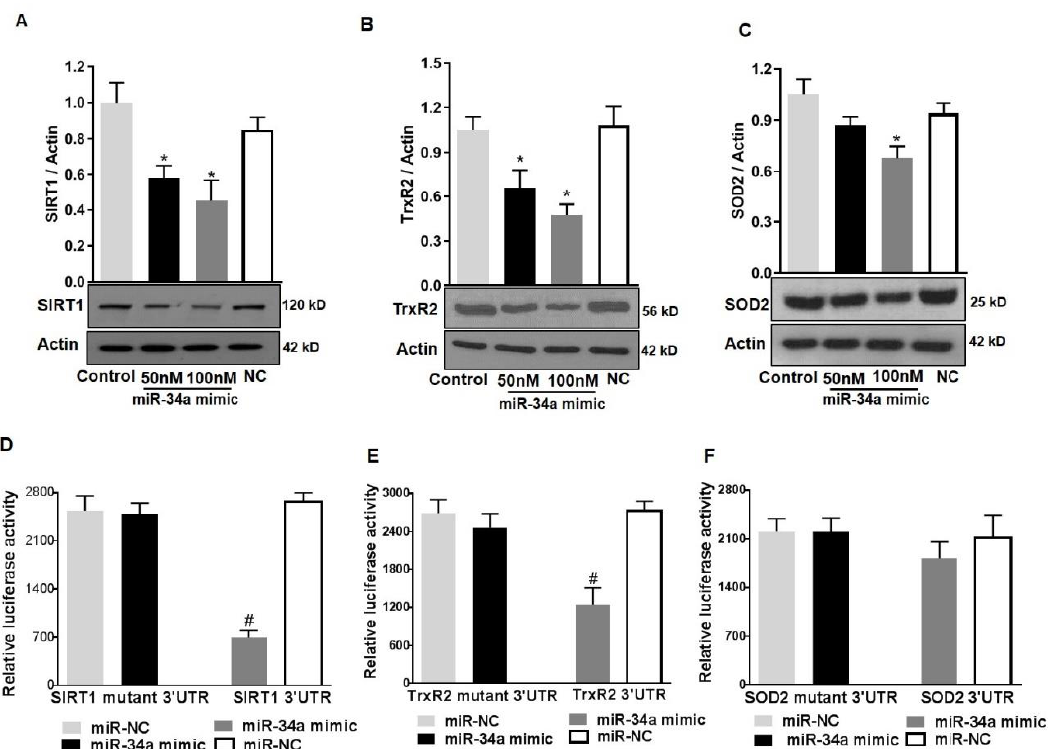
Figure 9. MiR-34a targets SIRT1 and TrxR2 but not SOD2 in HuREC. HuREC were transfected with 50 or 100 nM of miR-34a mimic or negative control (NC). Non-transfected HuREC cells were used as control. Immunoblotting analysis determining protein levels of ( A ) SIRT1, ( B ) TrxR2, and ( C ) SOD2 in HuREC transfected with 100 nM miR-34a mimic (black and dark gray bars), negative control (white bar), or control (light gray bar). Results of luciferase assay obtained to determine miR-34a binding to 3’-UTR binding of ( D ) SIRT1, ( E ) TrxR2, or ( F ) SOD2. HuREC were transfected with plasmid containing 3’-UTR of target gene (SIRT1, TrxR2, or SOD2) or plasmid containing mutated 3′ -UTR of target gene alone or in combination with miR-34a mimic. All transfections were carried out for 48 h and relative luciferase activity were determined using a commercially available luciferase assay kit. Bars represent mean value ± S.E.M; * p < 0.05 vs . control and # p < 0.05 vs . miR-NC, n = 4.